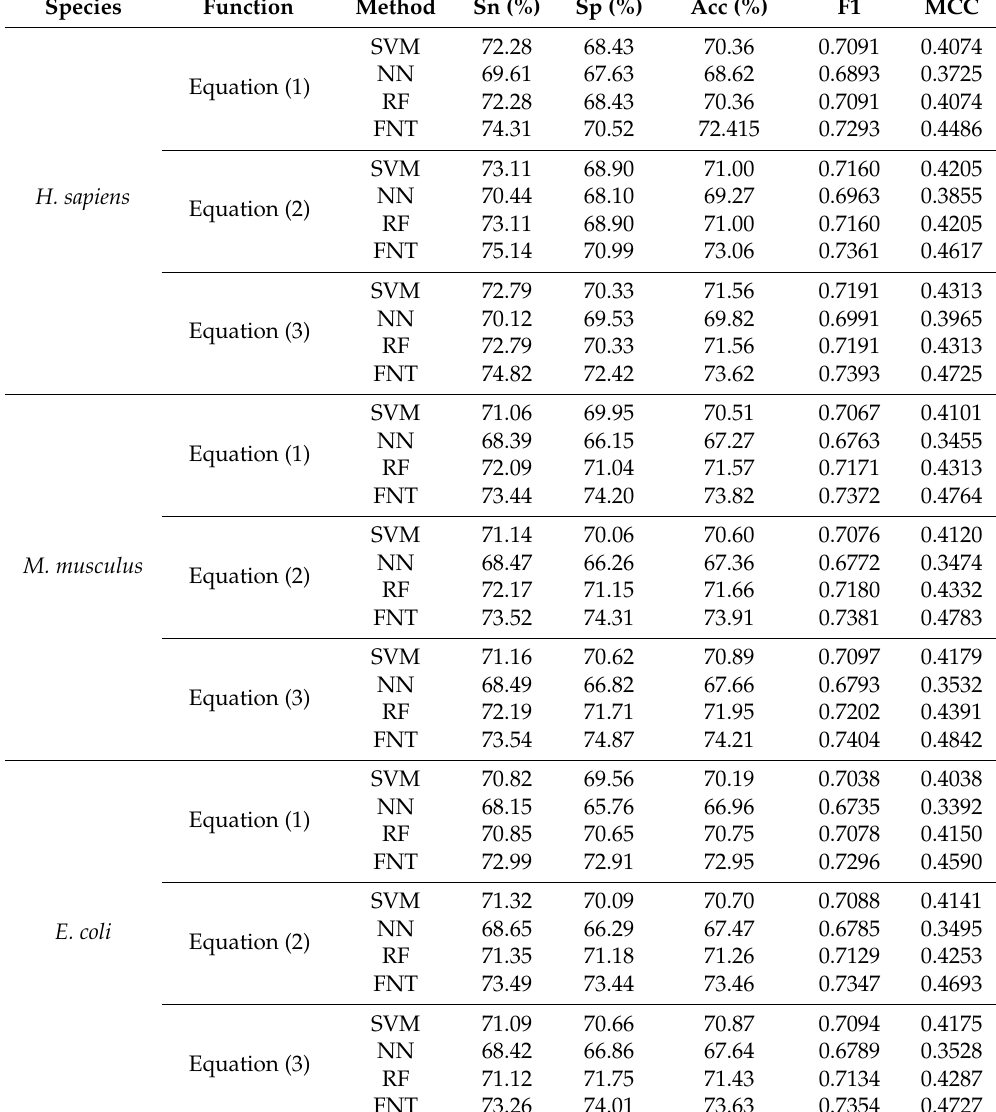
Table 8. Performance of different